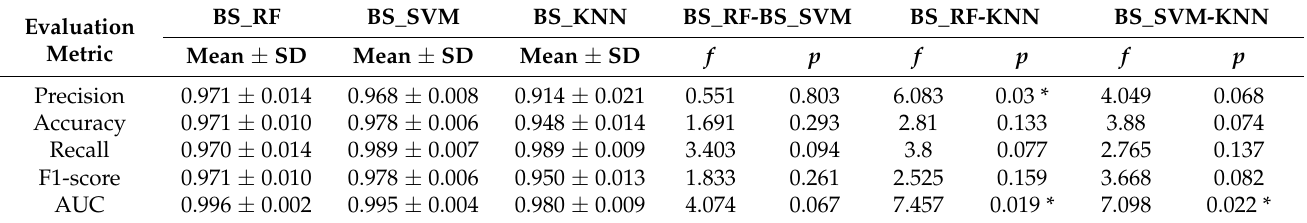
Table 8. Comparison of classification models after Borderline-SMOTE in different evaluation met- rics.